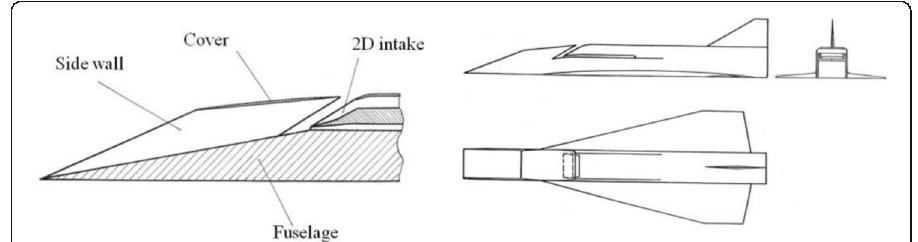
Fig. 10 Configuration of vehicle based on Busemann biplane concept